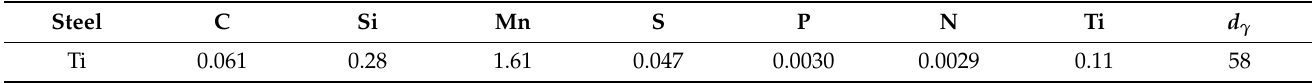
Table 1. Test steel chemical composition (wt.%) and grain size after austenitisation d γ ( µ